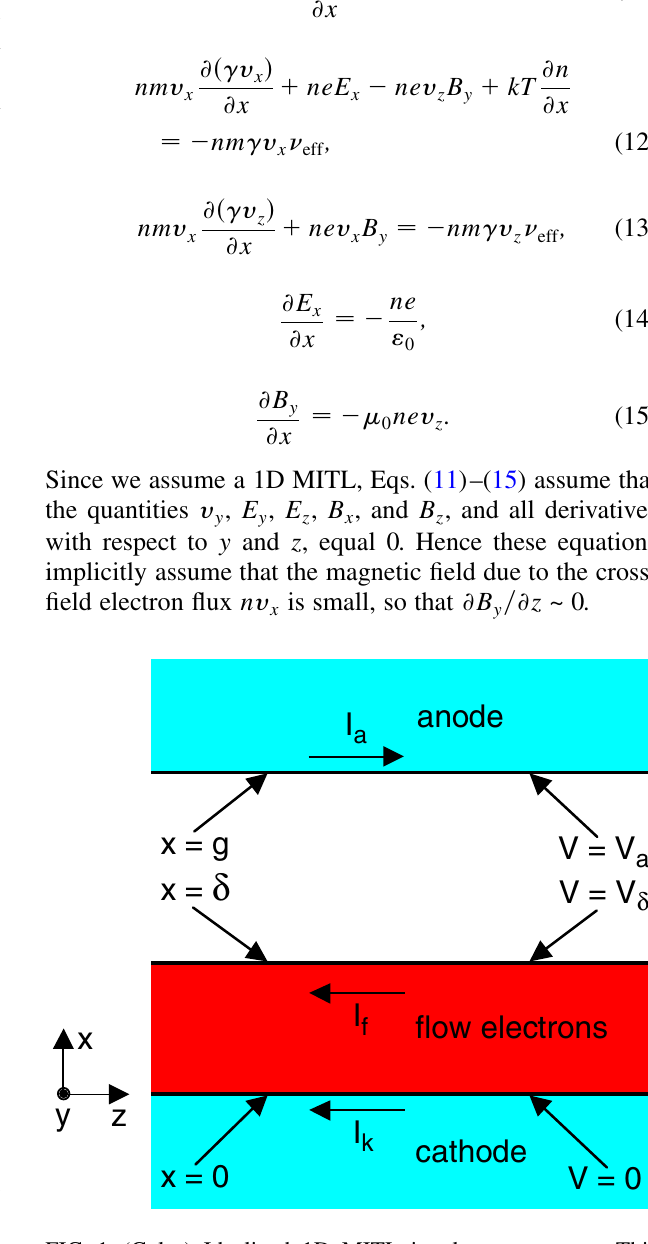
FIG. 1. (Color) Idealized 1D MITL in planar geometry. This figure assumes that the electromagnetic power flows in the positive z direction. The electric and magnetic fields are directed in the negative x and negative y directions,